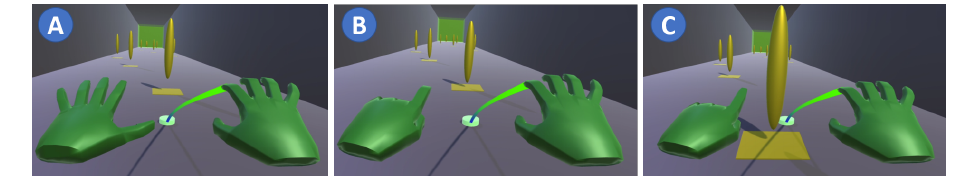
Figure 3. ( A ) Index finger of right hand points to desired position ( B ) Left hand performs teleportation gesture ( C ) User moved to position.